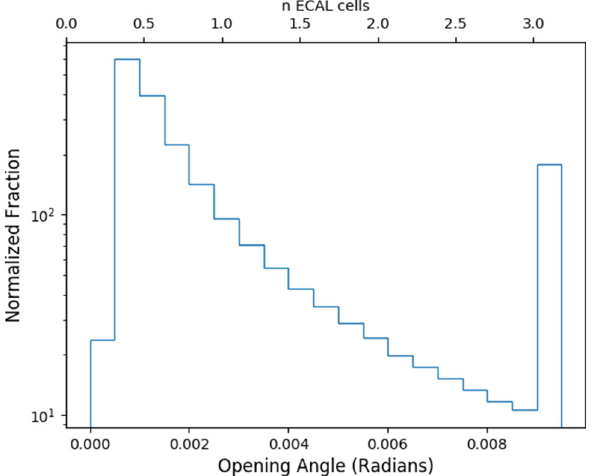
Fig. 4 Opening angle distribution for neutral pions decaying into two photons, plotted on a log scale with an overflow bin. Plot is zoomed in to show opening angle < 0.01. Number of equivalent ECAL cells is shown on the top axis. This plot was generated using pions from the full 2–500 GeV energy range